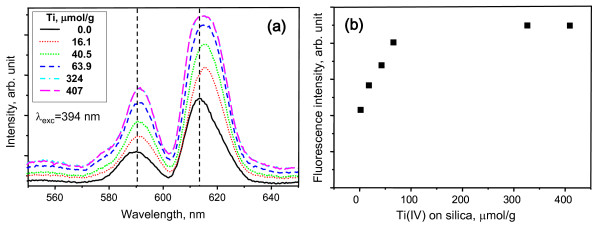
Fluorescence spectra and intensities of Eu(III) on partially Ti(IV)-coated silica. (a) Fluorescence spectra (λexc = 394 nm), and (b) fluorescence intensities (λexc = 394 nm) of Eu(III) on partially Ti(IV)-coated silica at 613 nm, according to the amount of coated Ti(IV) at pH 7.